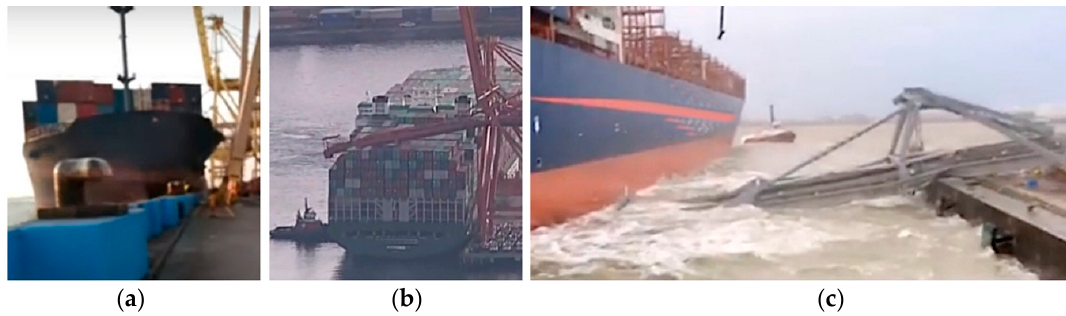
Figure 2. Container ship/crane collisions ( a ) with bow; ( b ) stern and ( c ) ships’ bridge wing. Table 1. Container ship / crane accidents in